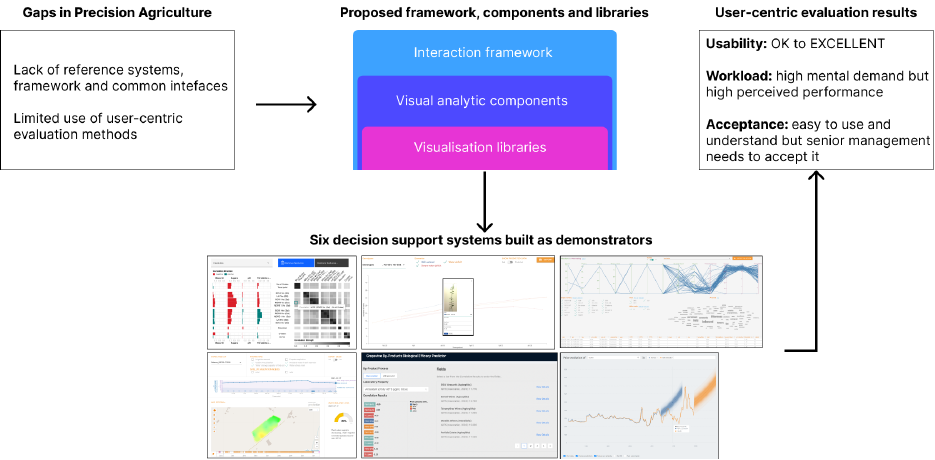
Figure 1. A graphical abstract highlighting the gaps in precision agriculture and contributions of this